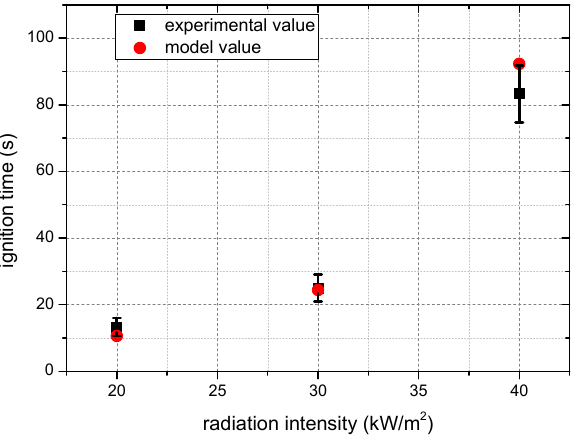
Figure 8. Comparison of cable ignition time.